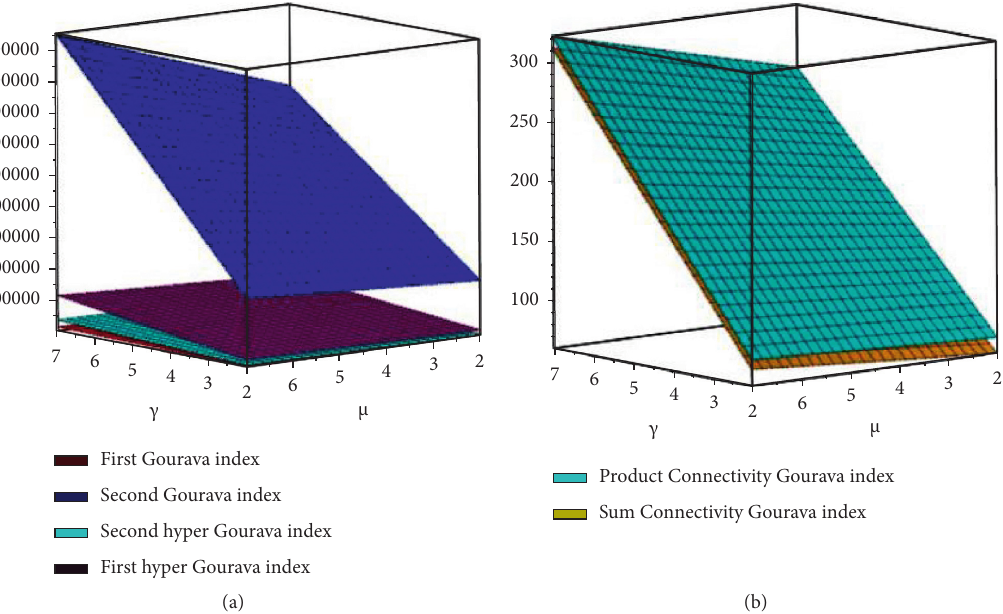
Figure 13: Graphical illustration of Gourava indices for AM c μ . (a) The first and the second Gourava indices and Gourava hyper-indices. (b) The sum and the product Gourava connectivity